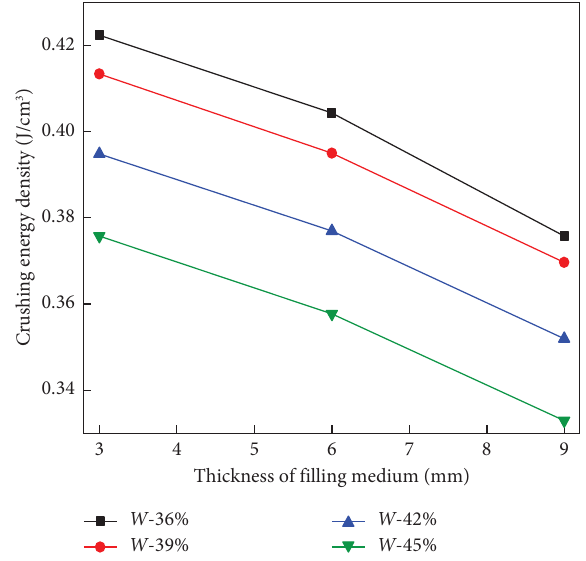
Figure 12: Variation law of crushing energy consumption density of composite